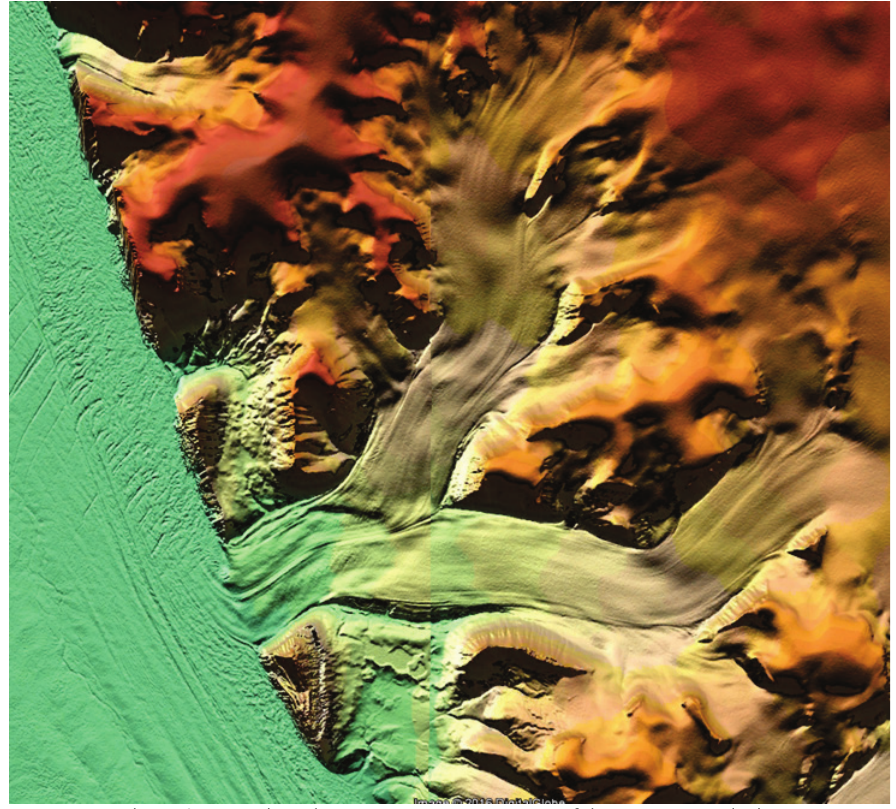
Figure 9. Zoom into the TanDEM-X DEM: Part of the Petermann